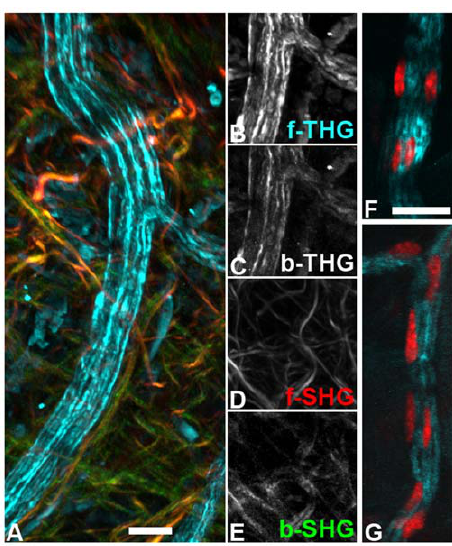
Figure 5. Nerve fibers in the cremaster. A) Unfixed, explanted muscle, projection of several optical sections covering 50 m m depth. Peripheral nerve (forward THG, cyan) surrounded by collagen fibers (forward SHG in red, backward SHG in green). Some blood vessels and small structures also produce THG signals. B–E) Single channel images of A near the nerve junction. Forward THG and SHG images have a much better signal to noise ratio than backward images. While forward and backward SHG signal differ substantially in some image details, backward THG (not included in A) does not contain any information in addition to the crisper forward THG image. F,G) Fixed cremaster with fluorescent DNA counterstain (red) and forward THG signal visualizing nerves. Several cell nuclei are associated with the nerve fibers. Scale bars are 20 m m, bar in F valid also for G.